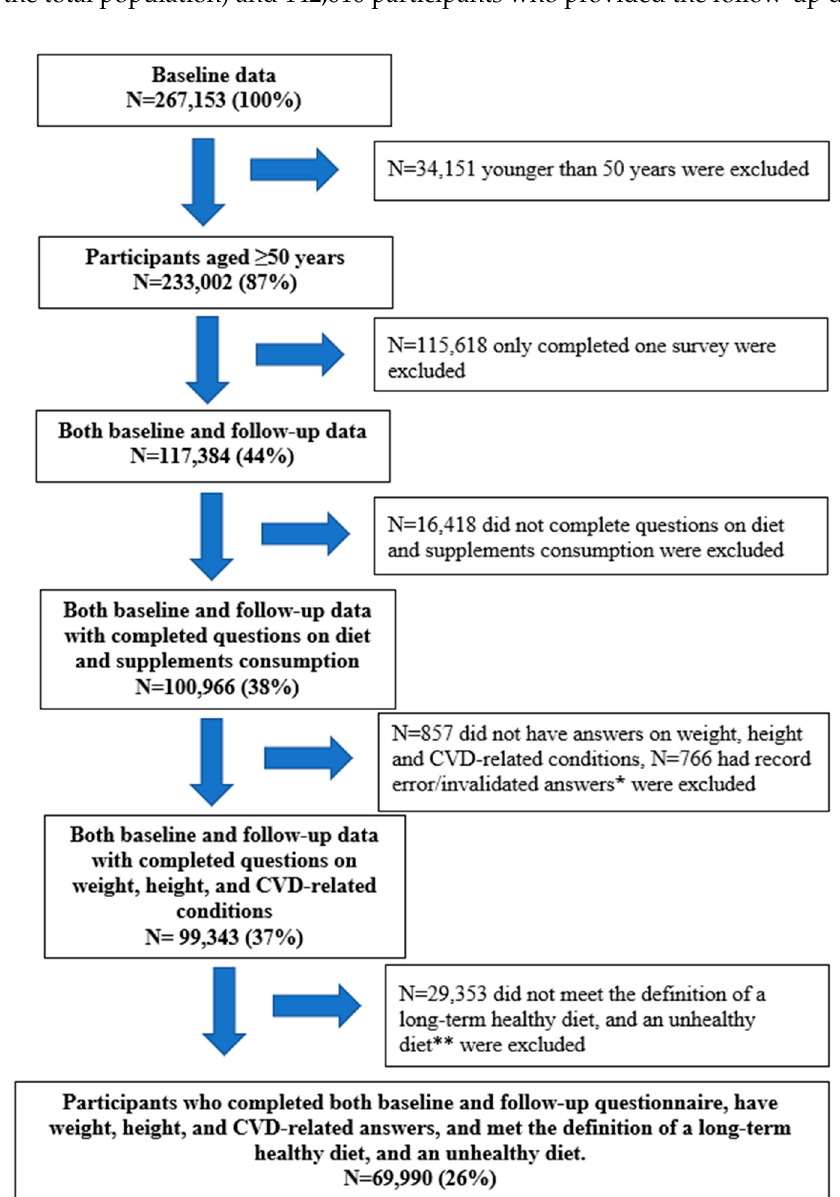
Figure 1. Study flow chart. * People who reported having cardiovascular disease (CVD)/obesity at baseline but had no CVD/obesity at follow-up. ** People who had a healthy diet/an unhealthy diet at baseline but had an unhealthy diet/a healthy diet, respectively, at follow-up.